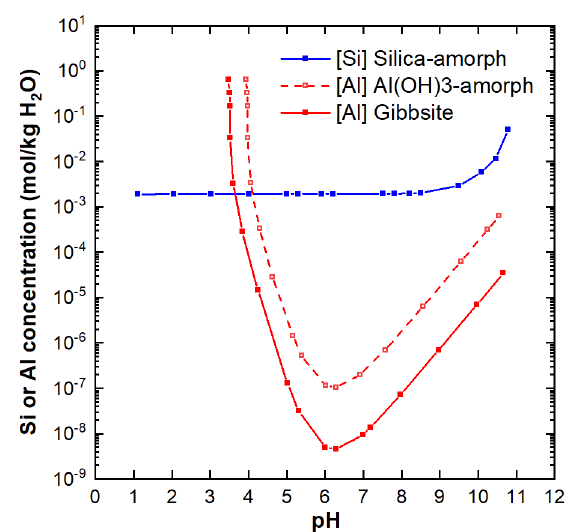
Figure 4. Solubilities of amorphous silica, amorphous Al(OH) 3 , and gibbsite versus pH at 25°C, 1 bar. (Data computed with GEMS [61,